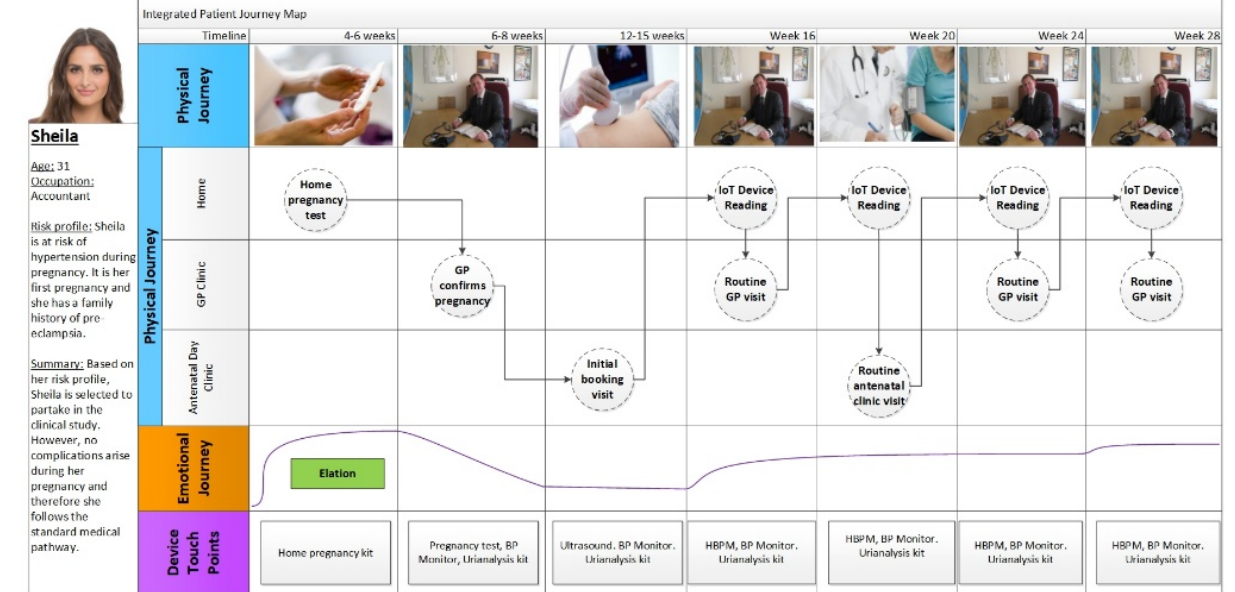
Figure 3. Snapshot of a Completed